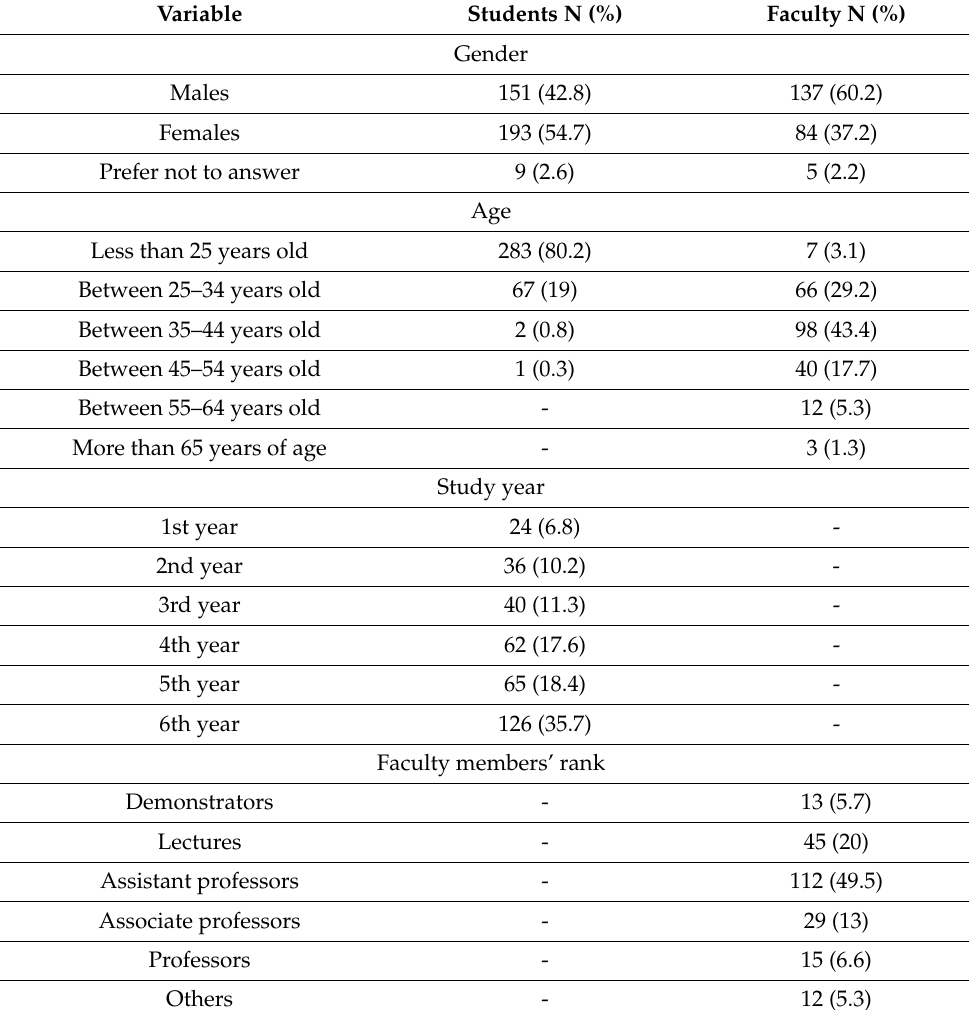
Table 1. Background profile of the participating students (N = 353) and faculty members (N = 226).